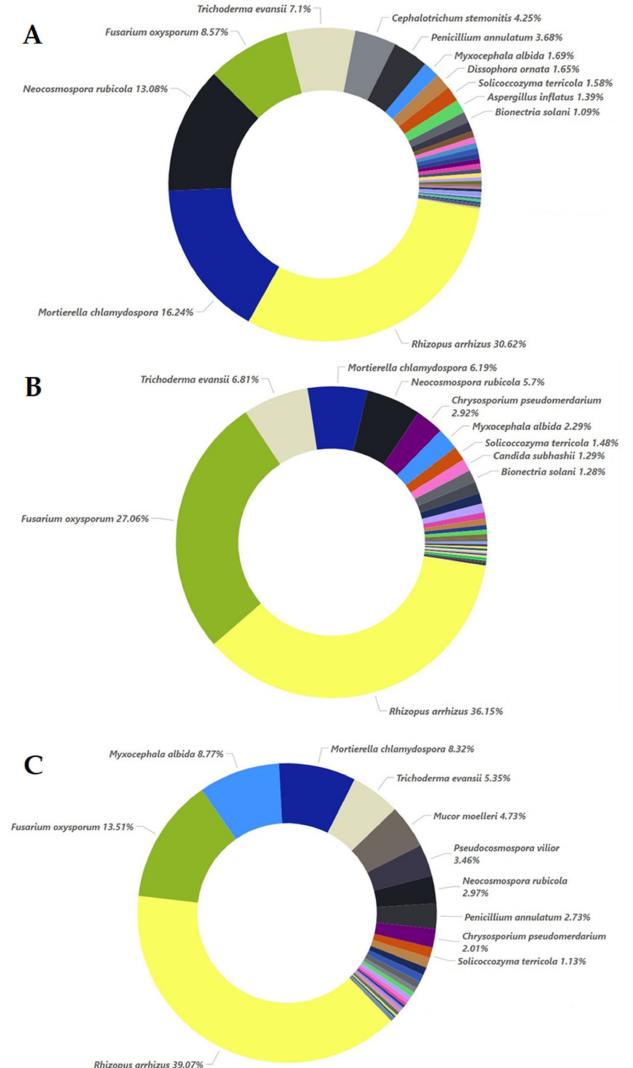
Figure 10. Relative species abundance with percentages higher than 1% for the inoculated samples at 0% ( A ), 5% ( B ), and 20% ( C ) essential oil